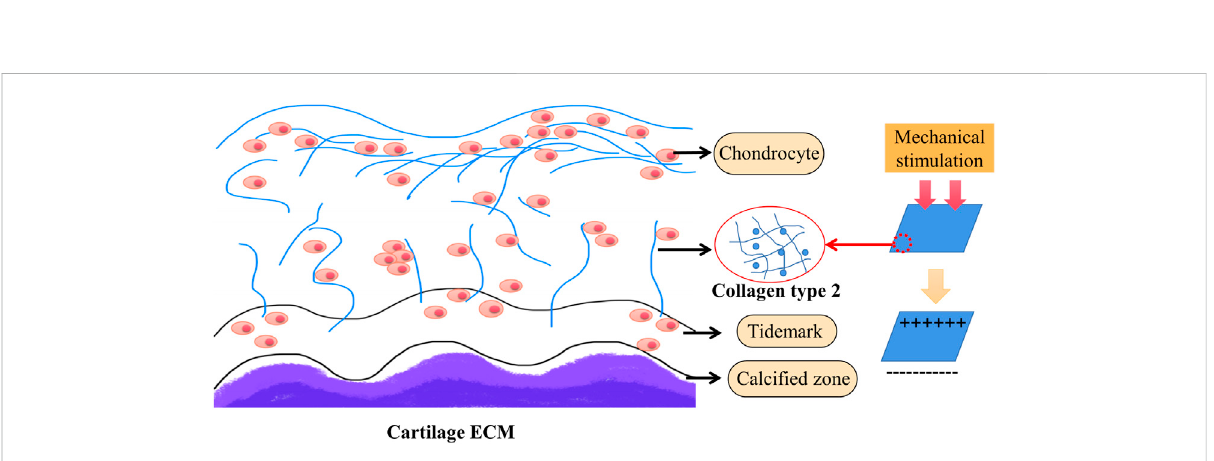
FIGURE 2 The mechanism of cartilage regeneration. Cartilage is rich in type II collagen. Piezoelectric collagen affects cell membrane receptors with changes in charge and ultimately acts on the nucleus to promote cartilage regeneration (Jacob et al., 2018; Jacob et al.,